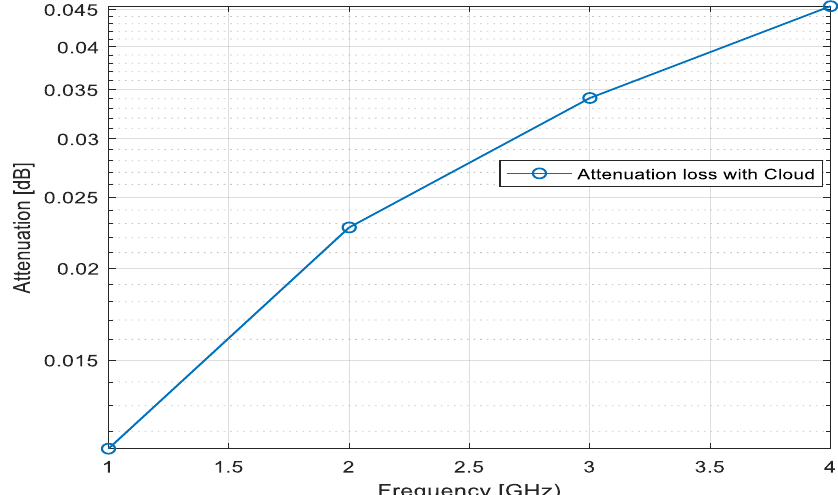
Figure 10. Attenuation due to cloud plot versus frequency.